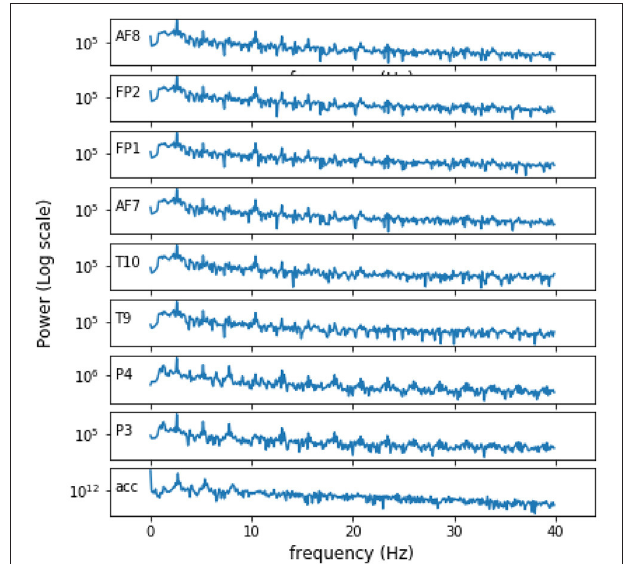
FIGURE 3 | Average spectral representation of the eight EEG signals and the accelerometer signal over 10 s of recording for the low MW and high PA condition.